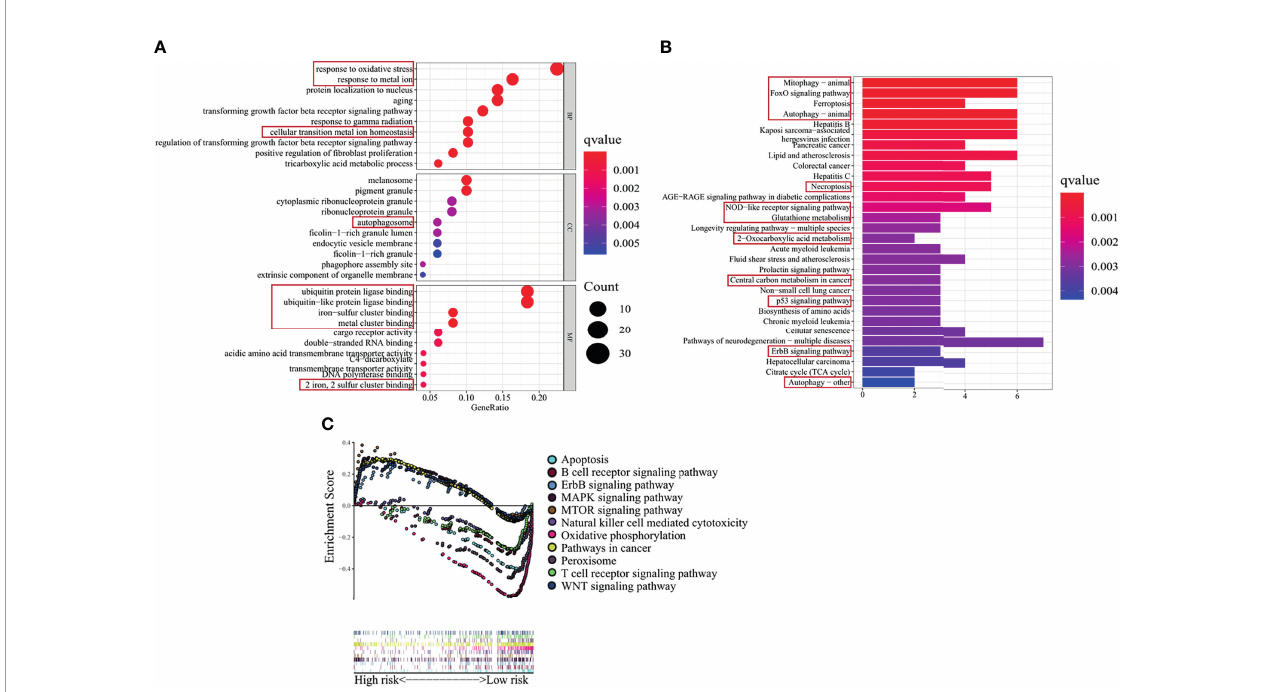
FIGURE 5 | Functional and pathway enrichment analyses in The Cancer Genome Atlas — stomach adenocarcinoma (TCGA-STAD) cohort. (A) GO and (B) KEGG enrichment analyses of ferroptosis-related genes differentially expressed in the high- and low-risk groups of TCGA-STAD cohort. The main focus is on the functions and pathways related to ferroptosis and tumor progression (framed by red boxes). (C) GSEA based on ferroptosis-related ncRNA signature. GO, Gene Ontology; KEGG, Kyoto Encyclopedia of Genes and Genomes; GSEA, gene set enrichment